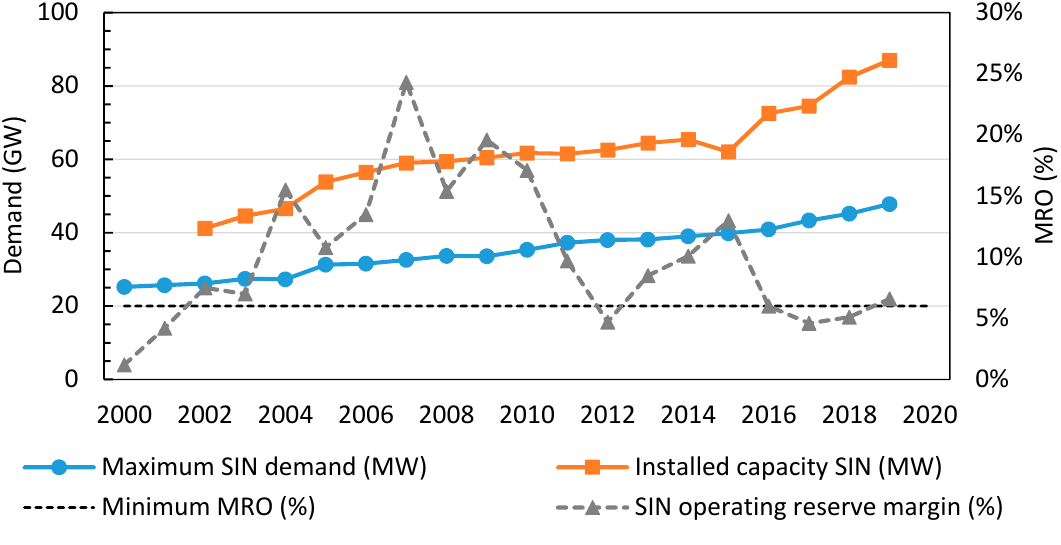
Figure 5. Installed capacity and operating reserve margin 2000–2019.